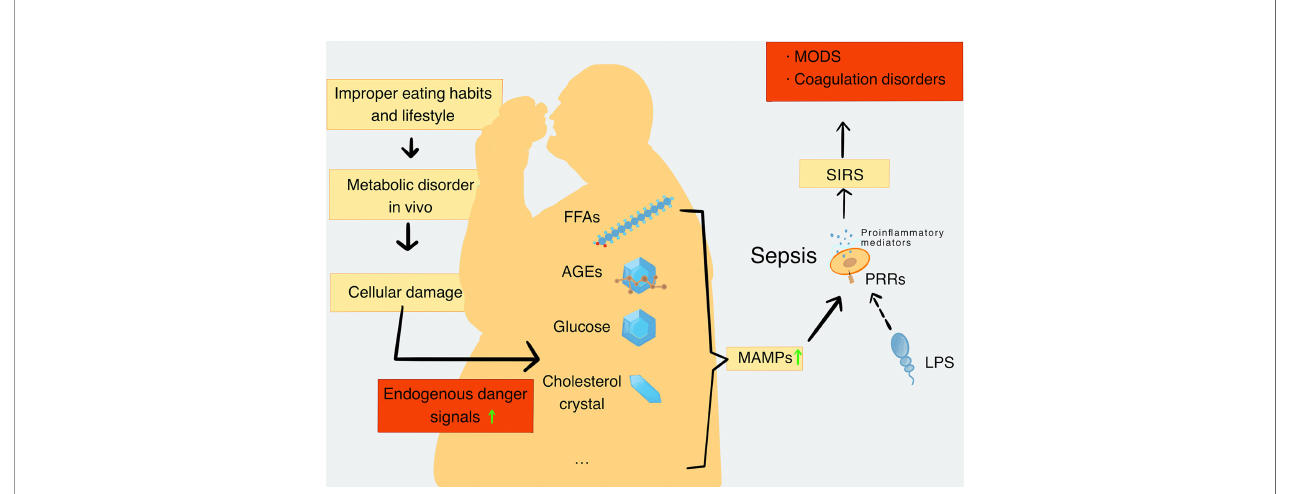
FIGURE 1 | The production and types of MAMPs and their role in sepsis. When the metabolic balance is broken, the metabolic disorders will lead to a decrease in repair ability of the body. Meanwhile, metabolic disorders can cause extensive cell damage in the body tissues. Cell damage leads to increased levels of endogenous danger signaling molecules, including FFAs, AGEs, glucose, cholesterol crystal, and mtDNA, which are closely related to metabolic disorders and are de fi ned as MAMPs. MAMPs can be recognized by PRRs and activate proin fl ammatory signaling pathways to promote the release of proin fl ammatory mediators. In addition, pathogenic substances such as LPS can also be recognized by PRRs and further activate the proin fl ammatory signaling pathway to cause the formation and deterioration of sepsis. Sepsis further enhances catabolism and increases MAMPs ’ levels in turn. With the development of SIRS, the in fl ammatory process becomes uncontrollable, and the organ function and coagulation function become abnormal. Finally, these disorders cause the formation of MODS. MAMPs, metabolism-associated molecular patterns; FFAs, free fatty acids; AGEs, advanced glycation end products; mtDNA, mitochondrial DNA; PRRs, pattern recognition receptors; SIRS, systemic in fl ammatory response syndrome; MODS, multiple organ dysfunction